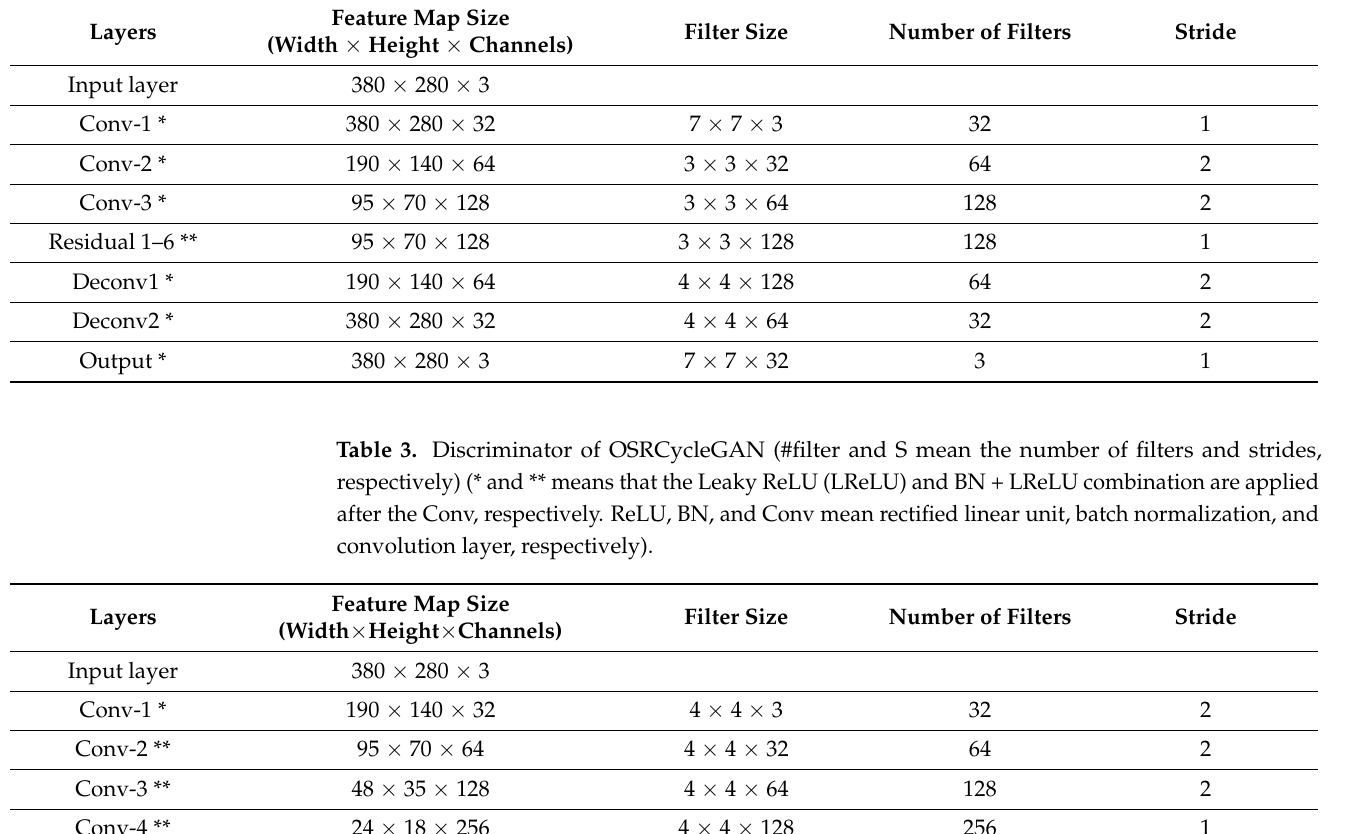
Table 2. Generator of OSRCycleGAN (* and ** means that the BN + ReLU and Conv + BN + ReLU + Conv + BN combinations are applied after the Conv or in each residual block, respectively. BN, ReLU, and Conv mean batch normalization, rectified linear unit, and convolution layer, respectively).